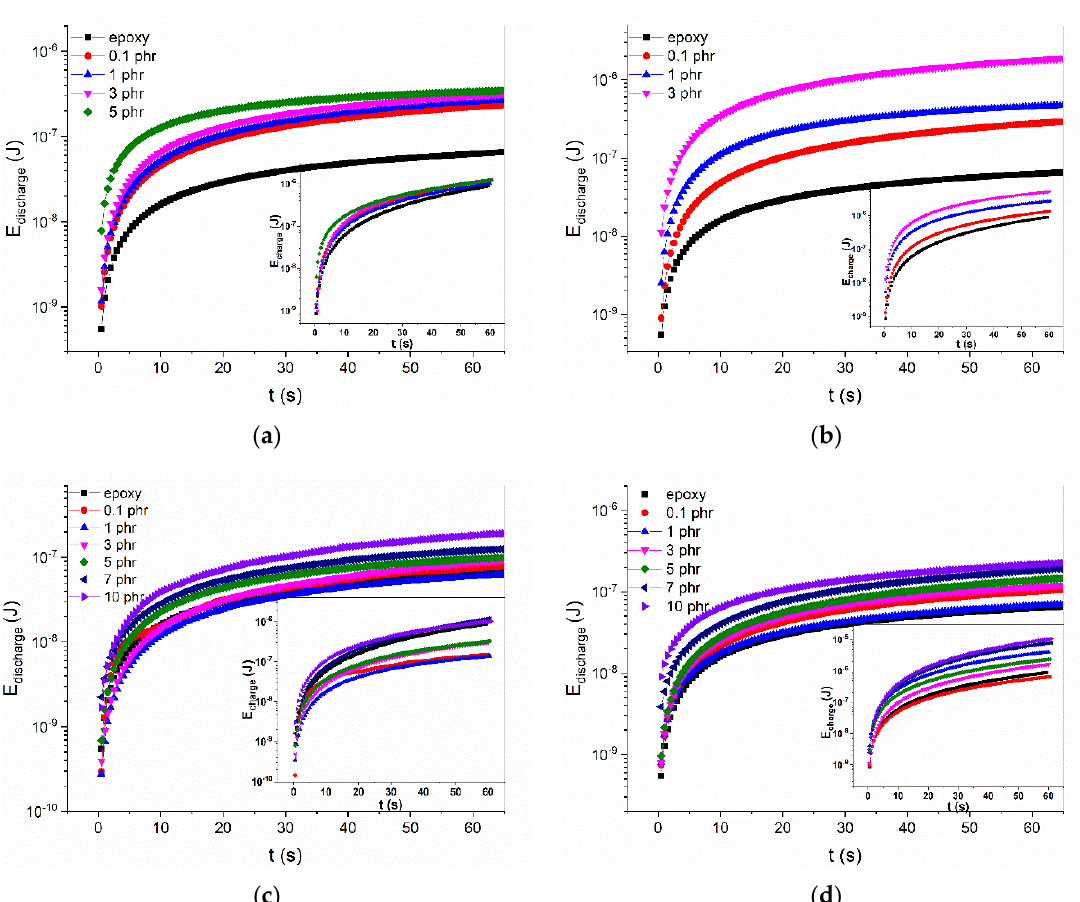
Figure 8. Comparative plots for the harvested energy, at 100 V, versus time for the nanocomposites with ( a ) carbon Black; ( b ) MWCNT; ( c ) GnP; ( d ) ND. Insets depict the stored (charging procedure) energies as a function of time for the respective systems.